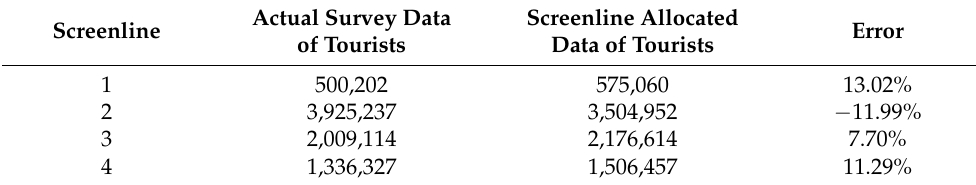
Table 8. Error analysis of